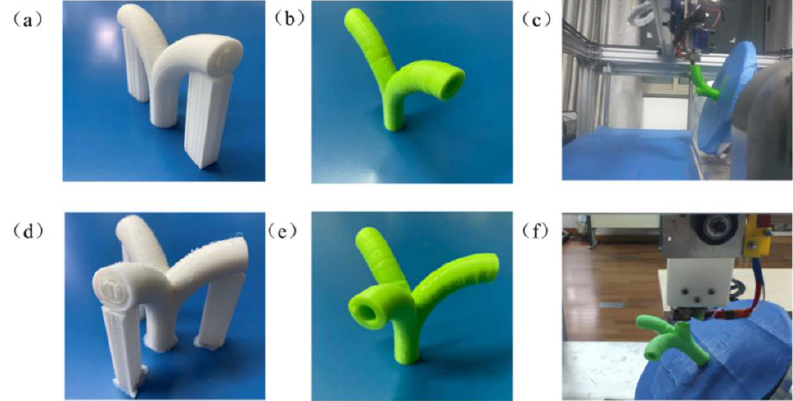
Figure 12. Multi-branched structure model printing: ( a ) two-branched pipe printed by conventional 3D printing, ( b ) two-branched pipe printed by non-directional unsupported printing, ( c ) the non-directional unsupported printing process of the two-branched pipe, ( d ) three-branched pipe printed by conventional 3D printing, ( e ) three-branched pipe printed by non-directional unsupported printing, and ( f ) the non-directional unsupported printing process of the three-branched pipe.